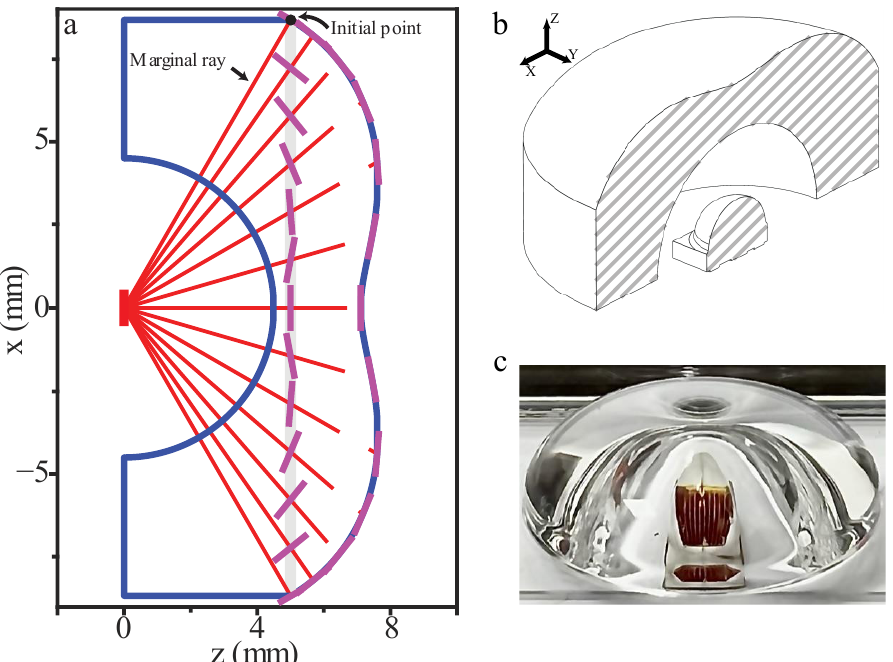
Figure 3. Lens surface construction. ( a ) 2D presentation of the numerical lens surface calculation by translation of refraction surface (purple lines) on principal plane (gray line) to the lens surface. ( b ) Final lens design cross-section on xz-plane. ( c ) manufactured lens and the LED assembly image.